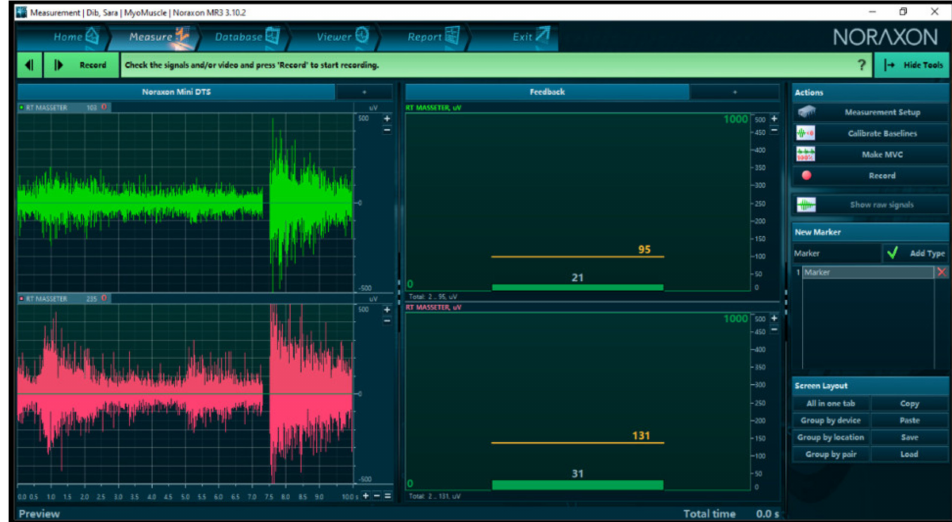
Figure 2. Electromyography surface electrode positioning.